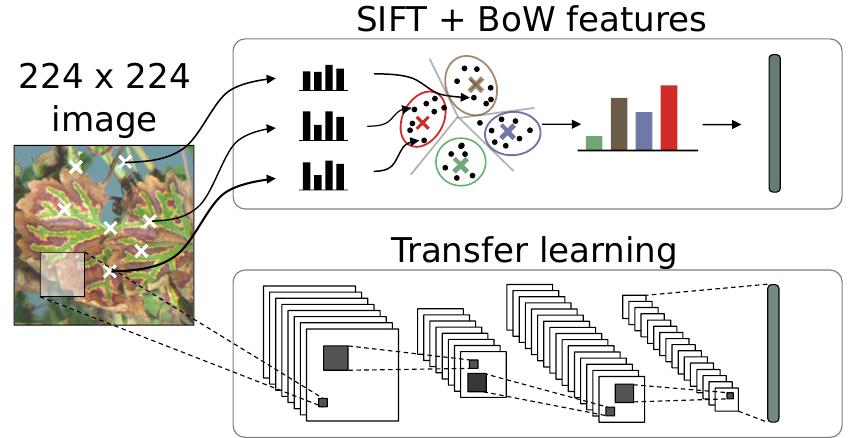
Figure 7. Comparative description of SIFT encoding and CNN transfer learning for the construction of informative